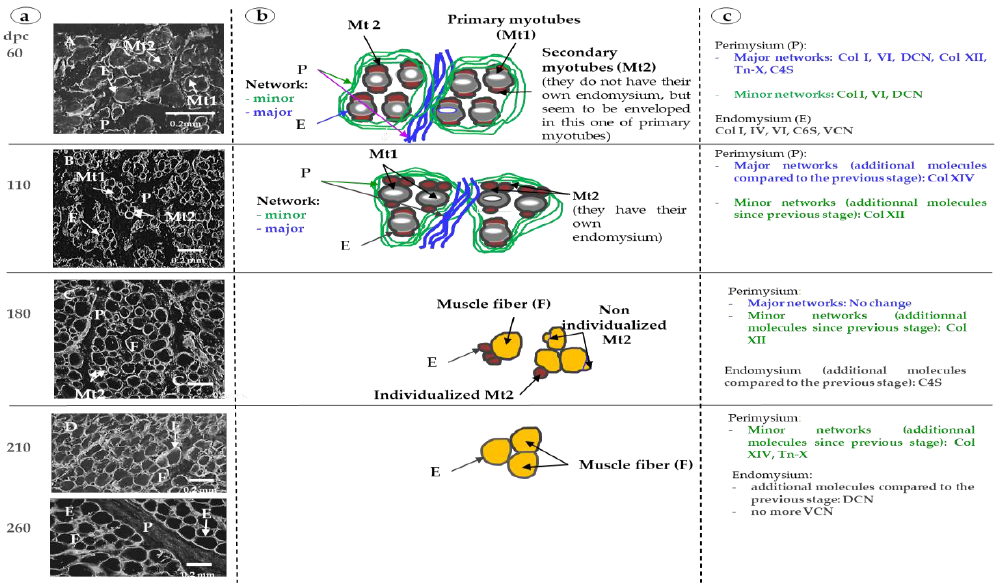
Figure 6. ( a ) The immunohistochemical labeling with antibodies directed against collagen IV ( A , B , C , D , E ) of transverse sections of fetal Semitendinosus muscle at 60, 110, 180, 210 and 260 days post-conception (dpc). (P: perimysium, E: endomysium, Mt1: primary myotubes, Mt2: secondary myotubes, F: muscle fiber). ( b ) Schematic representation of differentiation of muscle fibers at 60, 110, 180, 210 and 260 days post-conception (dpc). At 60 and 110 dpc, muscle fibers are present as primary (cells schematically represented by an oval grey form with a central lumen surrounded by a dark grey line representing endomysium) myotubes (Mt1) and secondary myotubes (Mt2) (cells schematically represented by a brown form without central lumen). At 60 dpc, Mt2 are not individualized; they are wrapped in the same endomysium than Mt1. At 110 dpc, almost all Mt2 are individualized and they have their own endomysium (dark grey line). At 180 and 210 dpc, some Mt2, individualized or not, are still present, but the majority of muscle cells are fibers (schematically represented by a yellow form surrounded by a dark grey line representing endomysium). At 260 dpc, all myotubes are muscle fibers. ( c ) Schematic description of localization of different molecules of ExtraCellular matrix. At each stage, the localization of ECM molecules (Col I, IV, VI, XII and XIV: collagen of type I, IV, VI, XII and XIV; DCN: decorin, TN-X: tenascin-X, C4 and 6S: chondroitin 4 and 6 sulfate; VCN: versican) is indicated in the major and minor networks of perimysium and in the endomysium. From 110 dpc, only the modifications of localization of ECM molecules are indicated.